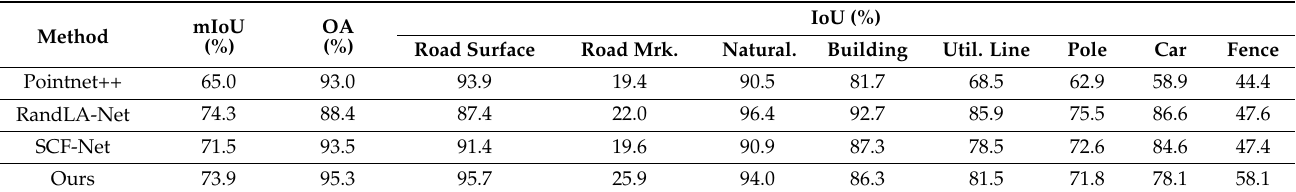
Table 1. Semantic segmentation (L002) results of Toronto-3D dataset %.